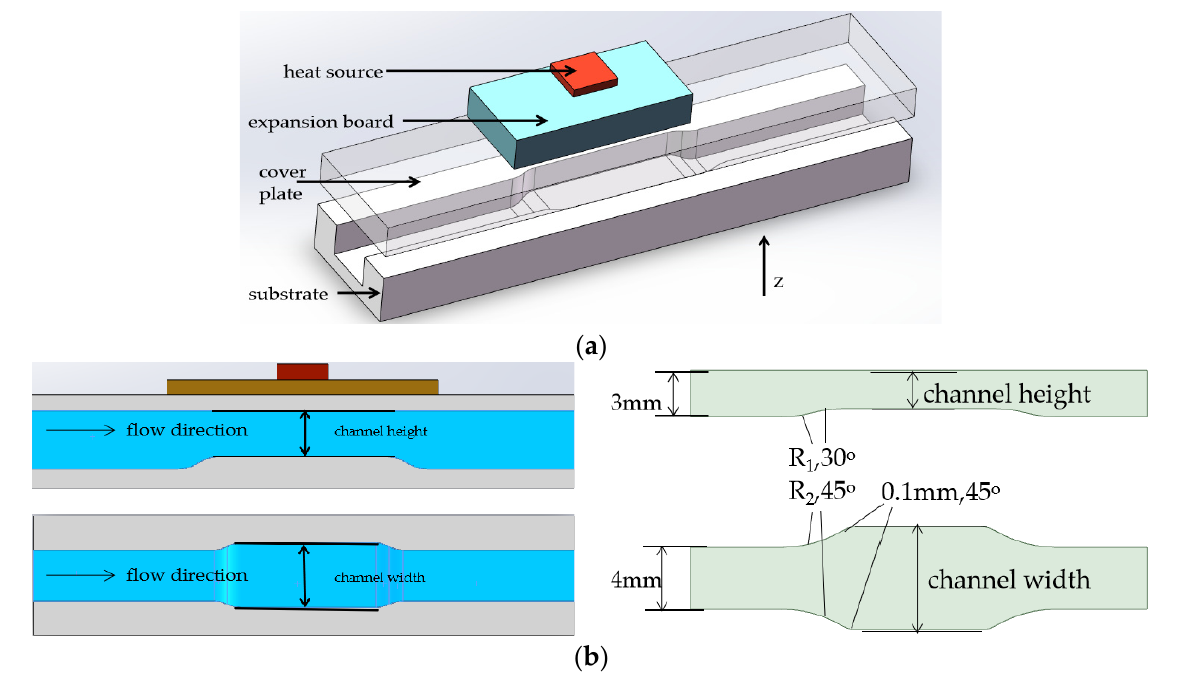
Figure 2. Schematic diagram of ( a ) structure of channel with variable cross-section; ( b ) channel section and dimensions.